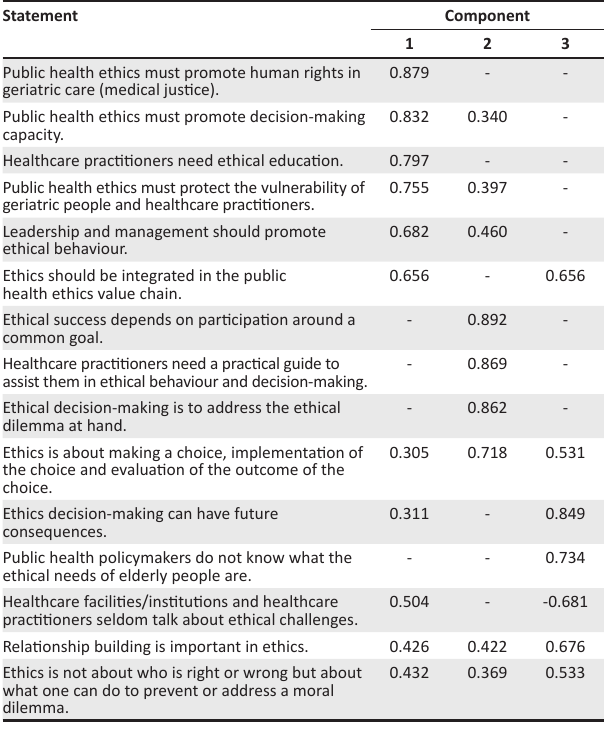
TABLE 2: Rotated component